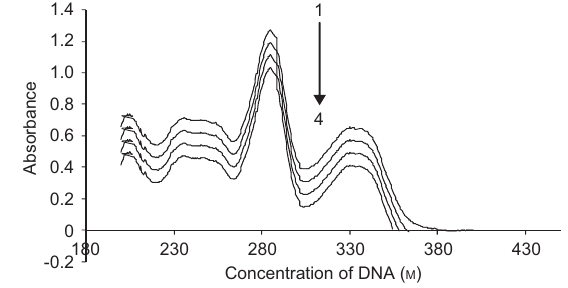
Figure 13 UV/VIS absorption spectra of 1.4 × 10 -4 m gatifl oxacin in acetate buffer solution (pH 5) in the presence of DNA ( m ): (1) 0.00, (2) 3.17 × 10 -4 m , (3) 3.7 × 10 -4 m , (4) 4.5 2 × 10 -4 m .